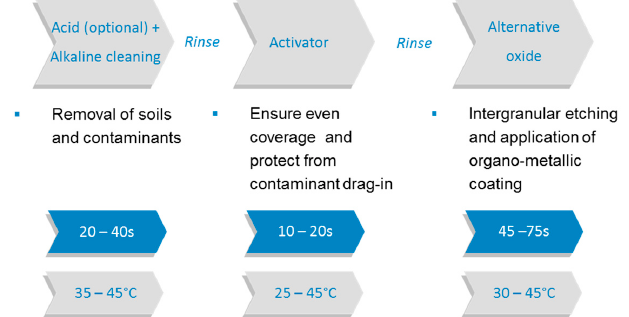
Figure 3. Schematic flow chart of the alternative oxide process.